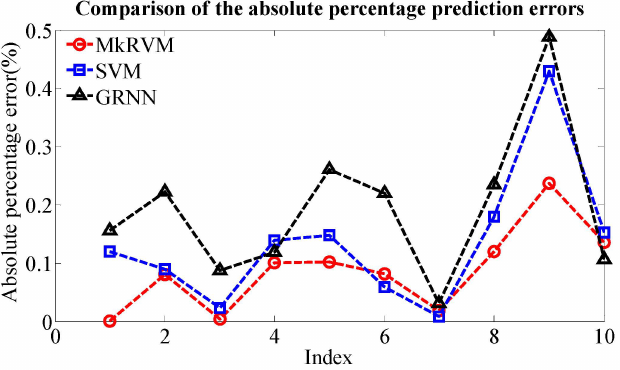
Figure 15. The comparison of the absolute percentage prediction errors among the MkRVM, SVM and